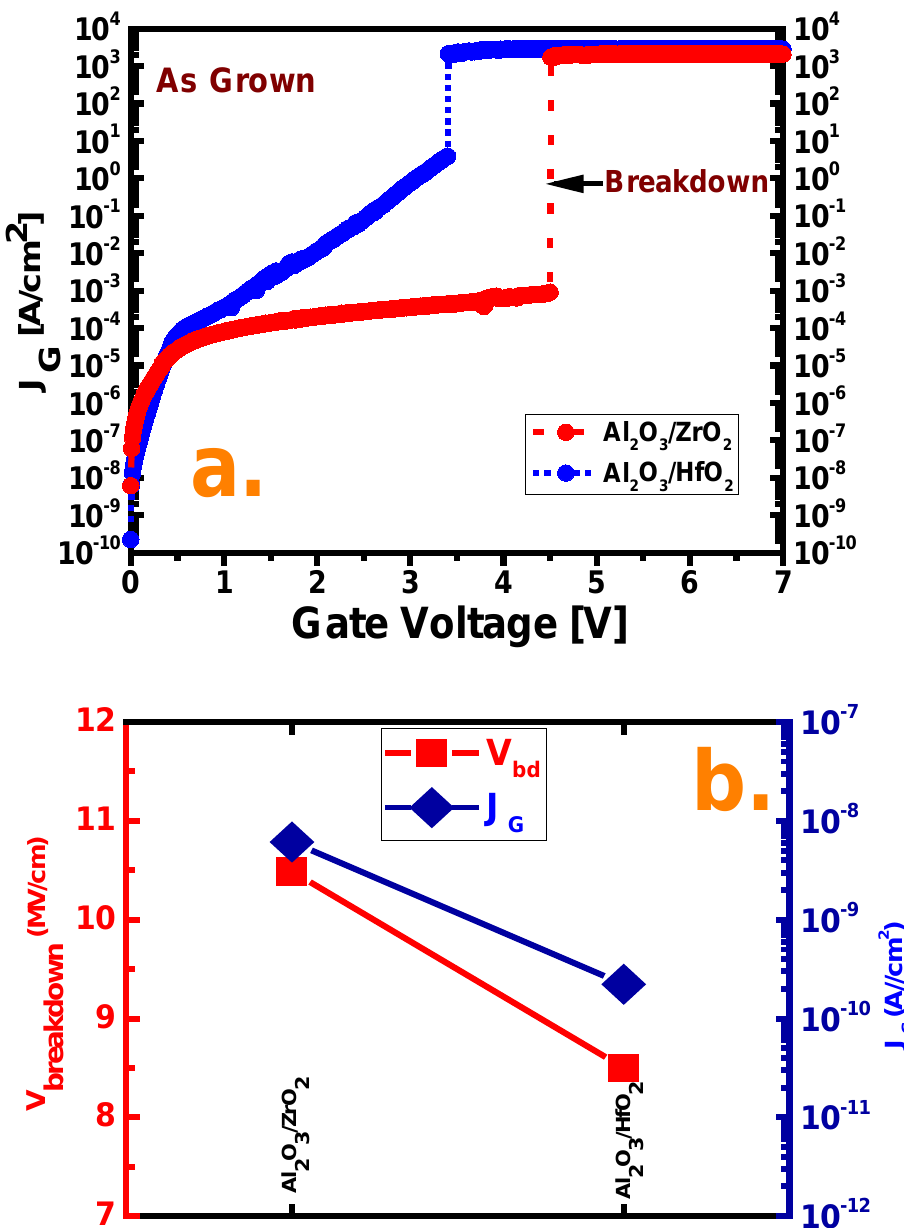
Figure 5. ( a ) Leakage current-voltage (J–V) profile under a positive gate voltage and ( b ) breakdown voltage (V BD ) and leakage current density (J G ) comparison for all deposition